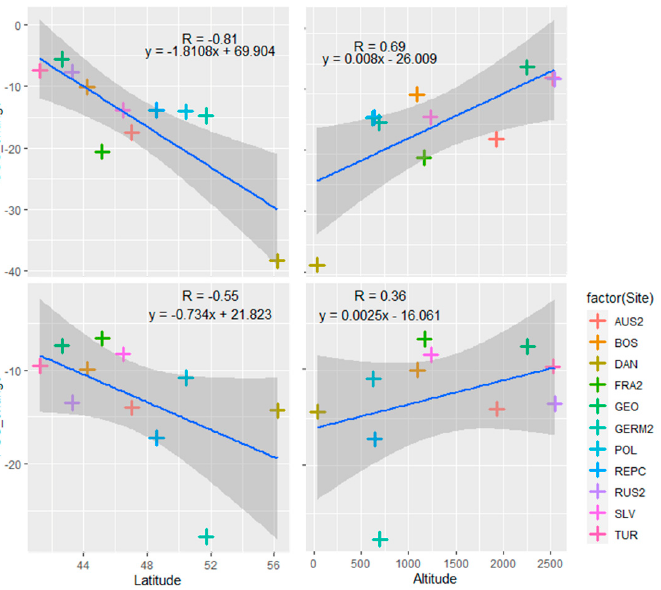
Figure 6. SOS and POS changes during the period 2001–2021 compared with the latitude and altitude of the sites where changes are significant in both SOS and POS. In addition to the analysis of the changes that occurred in SOS and POS over the reference period, changes in the duration of the timeframe between SOS and POS (i.e., SOS-POS duration) were also analysed (Figure 7).